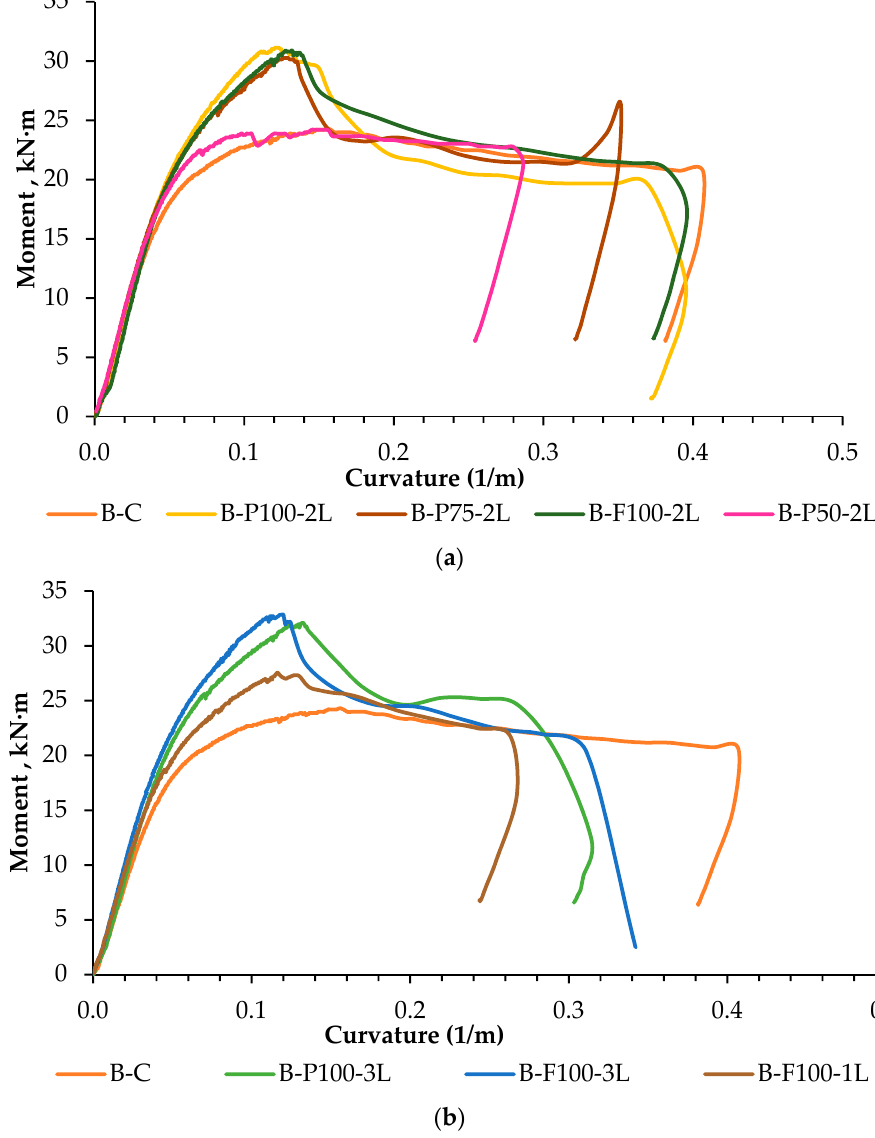
Figure 8. 8 relationship of HPCFDST beams ( a ) control beam, partial, and full strengthening with 2 layers of CFRP, and ( b ) control beam, partial (3 layers), and fully strengthening (1 and 3 layers) with various CFRP layers.